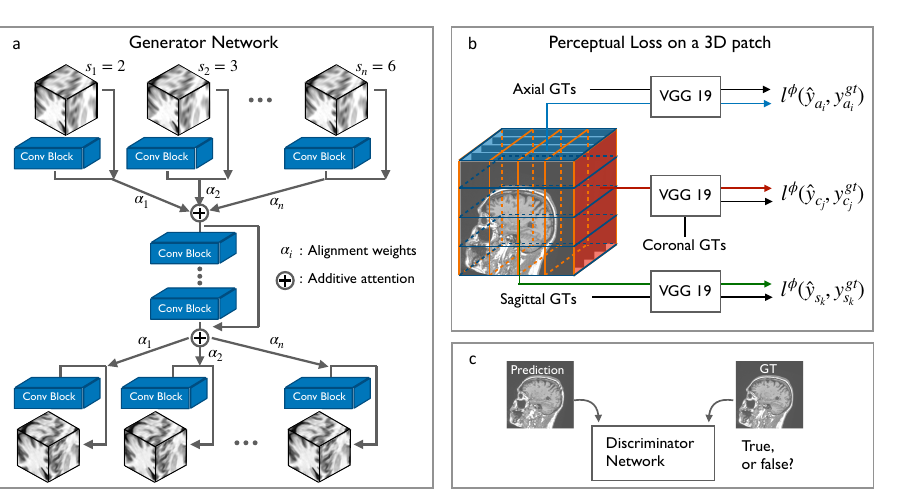
Figure 1. ( a ) Architecture of our scale-attention SR network with GAN. ( b ) Three-dimensional perceptual loss is calculated by inputting all the axial, sagittal, and coronal surfaces of the 3D data into the pre-trained VGG and ( c ) comparing the differences between predictions and ground-truths in the high-dimensional feature space. GT: ground